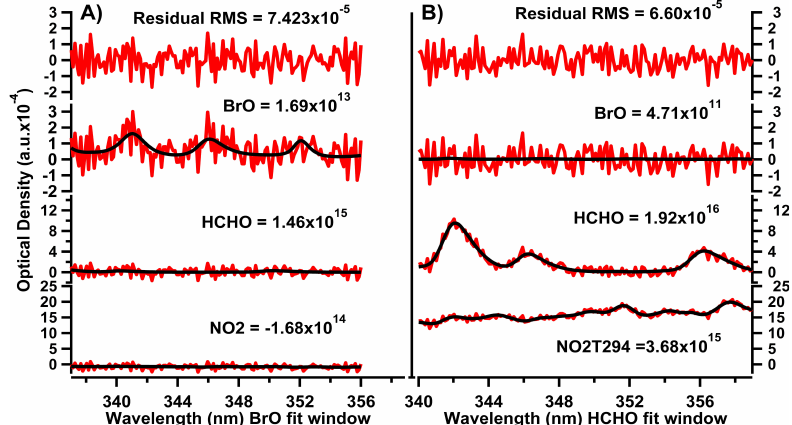
Fig. 7. Spectral proof for the detection of BrO and HCHO. All spectra were analyzed for BrO in the 340–359nm range and for HCHO in the 337–359nm range. (A) : the BrO fit is from 2 April 2010 at 19:36UTC in the 155 ◦ viewing angle, and (B) : the HCHO fit is from 8 May 2010 at 20:28UTC in the 25 ◦ viewing angle.